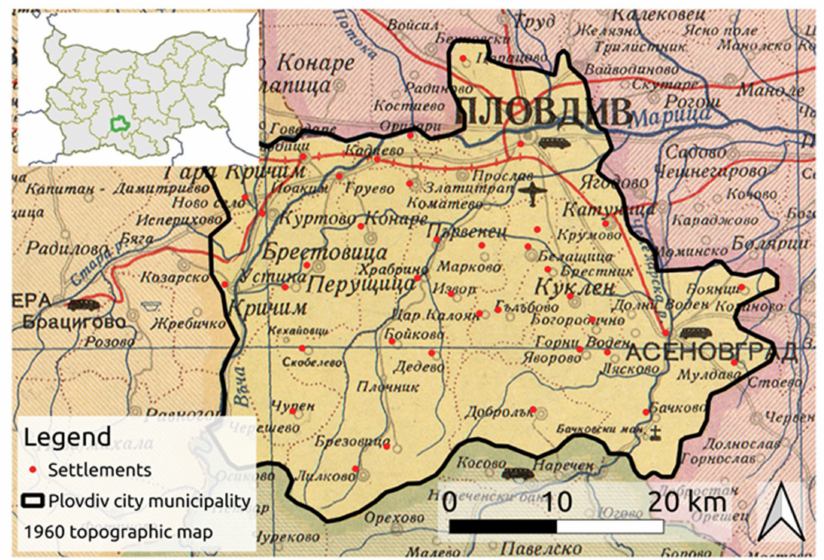
Figure 1. Study area of the city municipality of Plovdiv (black outline) overlaid on a georeferenced historic administrative map from 1960 and the location of the sampled 39 settlements (red points). Inset image presents the relative location of the city municipality of Plovdiv in the context of Bulgaria. The historic background map was issued by the Bulgarian State Directorate of Geodesy and Cartography under the title of “Administrative map of People’s Republic of Bulgaria”, ID KpIV314, designed in 1960 and printed in